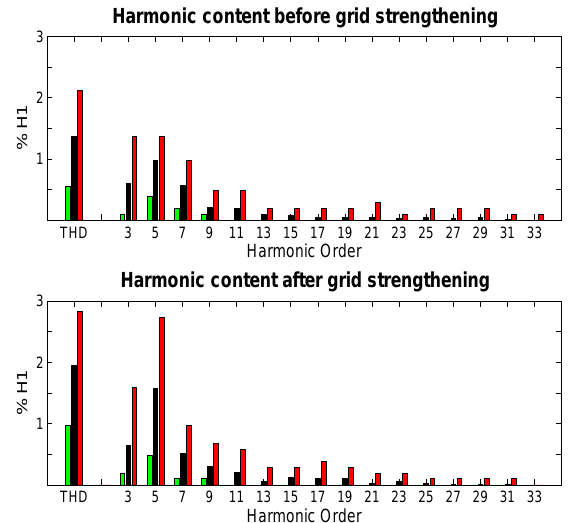
Figure 10. Voltage THD and harmonic content during one day before the grid strengthening ( above ) and after the grid strengthening ( below ). The green bar represents the minimum harmonic content values; the black bar represents the medium harmonic content values and the red bar represents the maximum harmonic content values.